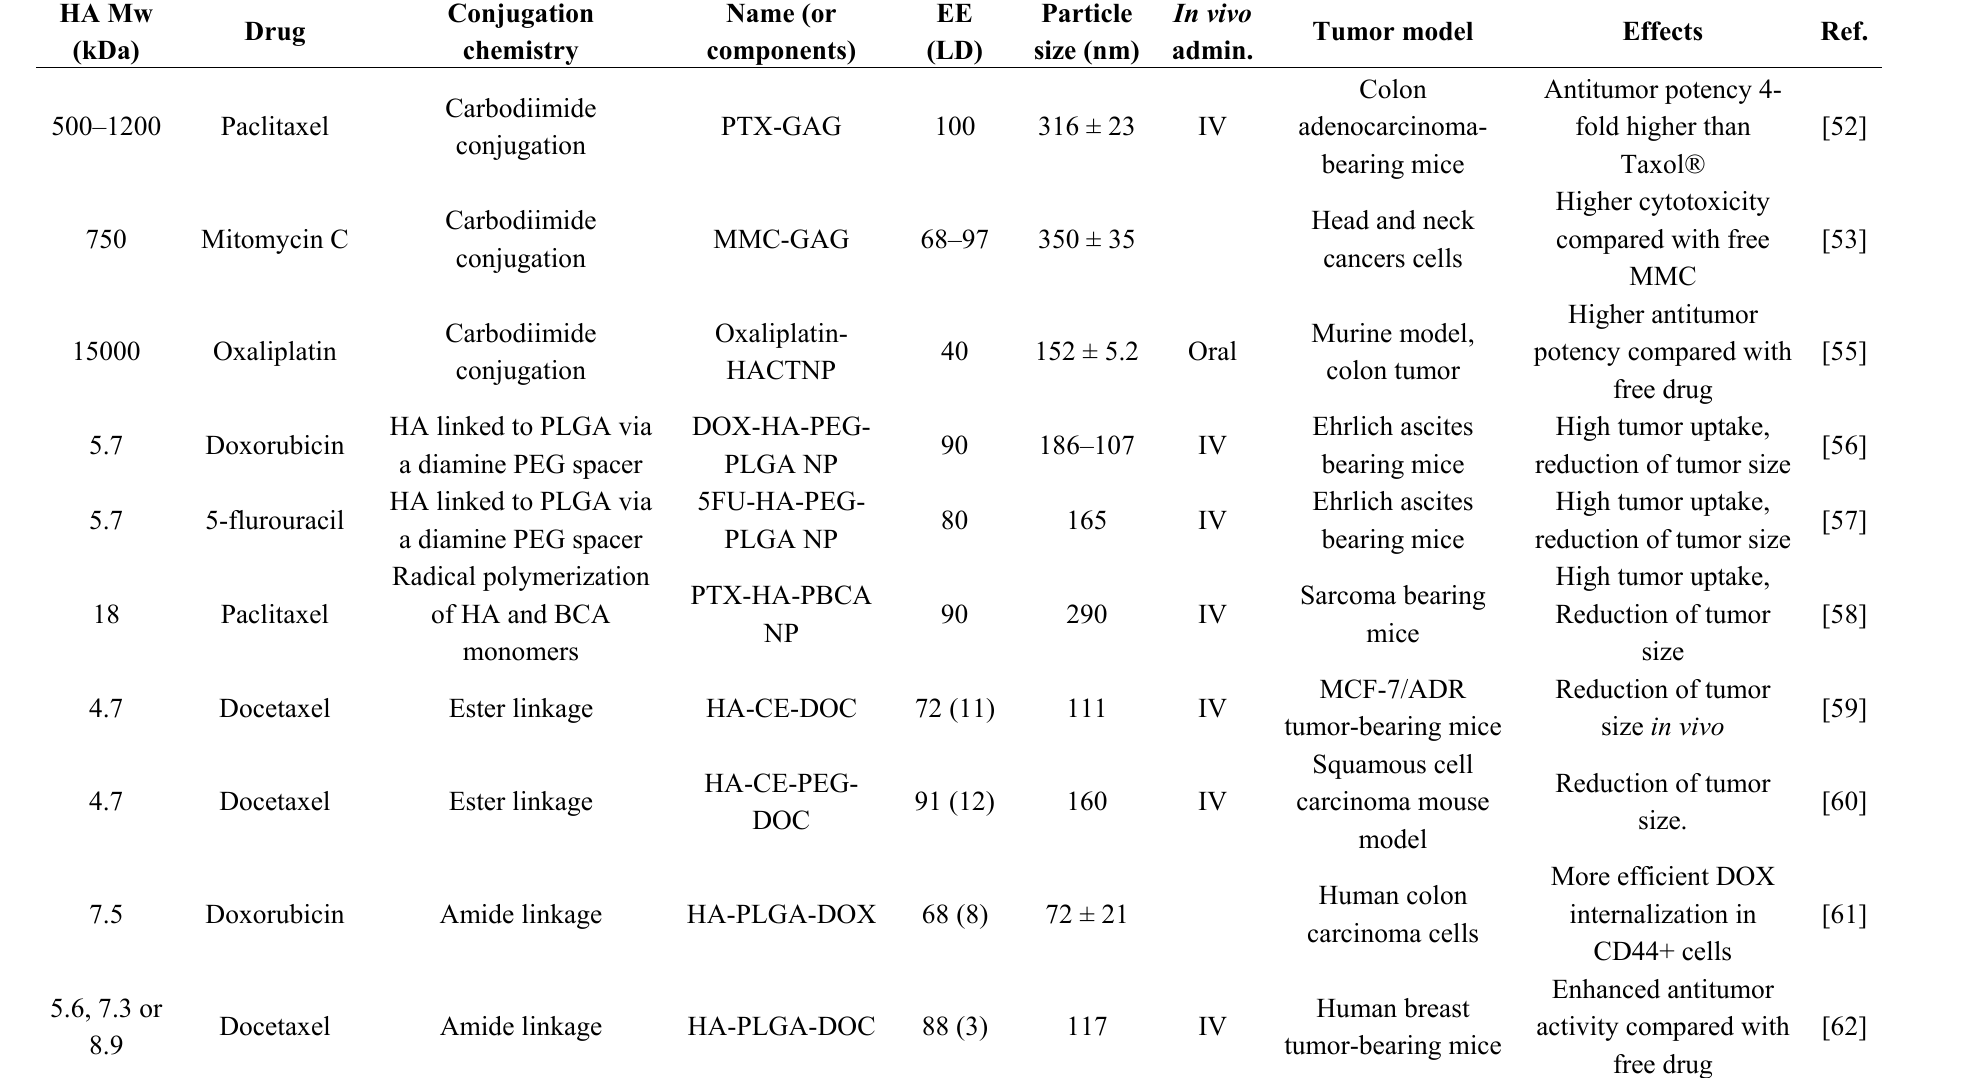
Table 2. Summary of the characteristics of the principal HA-nanoparticle and microparticle